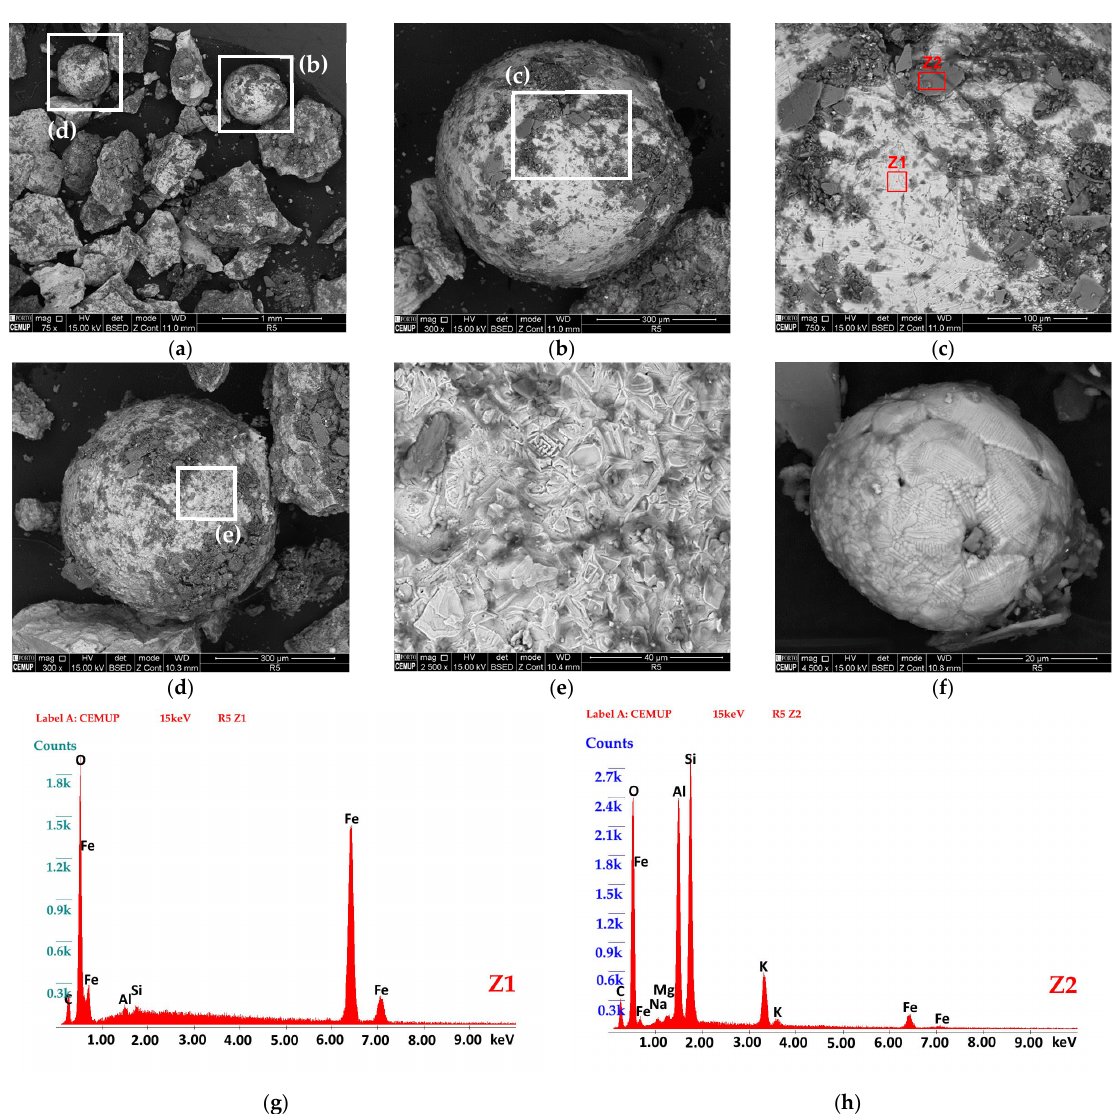
Figure 13. ( a – f ) SEM images showing the morphological variety of spherical components of the magnetic fraction in sample R5; ( g , h ) two chemical composition spectra in a massive magnetic spherule from R5 sample (see the location of the spectra Z1 and Z2 in Figure 12c). Chemical composition spectra (EDS spectra) showed that in the massive magnetic spherules both pure Fe-containing spherules and a complex mixture of aluminosilicates and Fe-bearing compounds were present (Figure 13g,h). Other components of magnetic fraction were found in the magnetic fraction, such as iron fi lings, probably due to the deterioration of the metallic parts of the remaining wash- ing plant. 4.3. Plant Analysis Several elements considered as PTEs in soils are known plant micronutrients, such as Mn 2+ , Zn 2+ , Cu 2+ , Ni 2+ , connected with the enzymatic components, or bene fi cial nutrients (Co 2+ ). So, it is expected to fi nd them as part of the composition of several plant tissues. Although measured with di ff erent methods, it can be con fi rmed that the levels of PTEs in the soils had a considerably lower quantitative correspondence in the plants, with median levels ranging from 0.0 to 0.82 mg/kg (Table 2). This might point to either the PTEs’